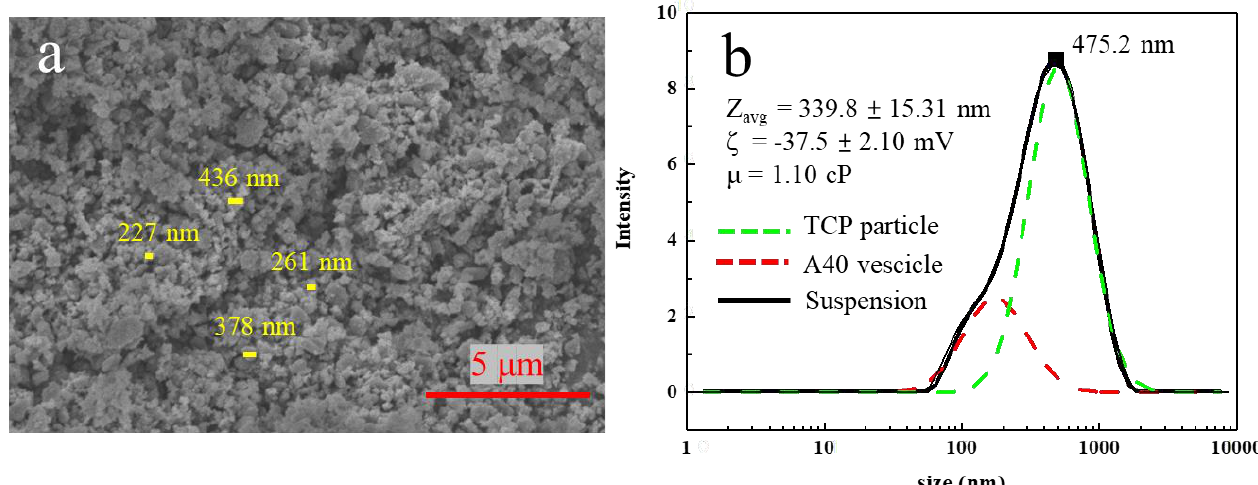
Figure 4. ( a ) SEM image of original β -TCP particles. ( b ) Size distribution for β -TCP suspension with 0.3 wt% A40 after ball milling and resuspension.